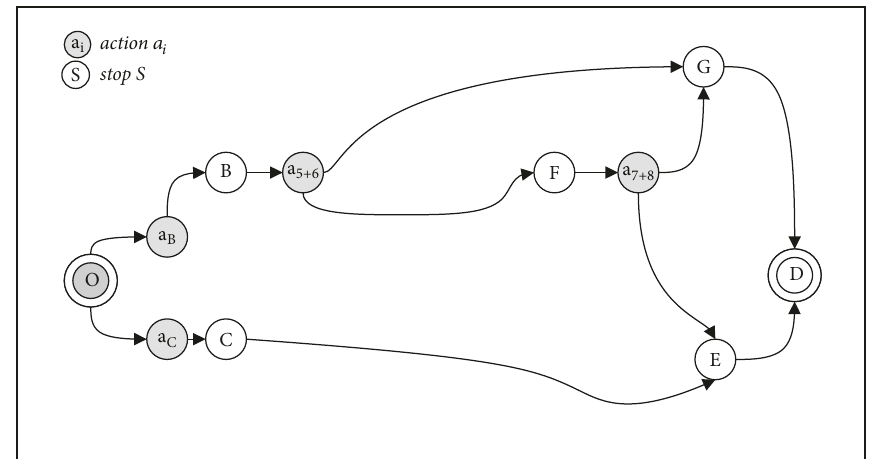
Figure 5: Example of reduced action tree of Figure